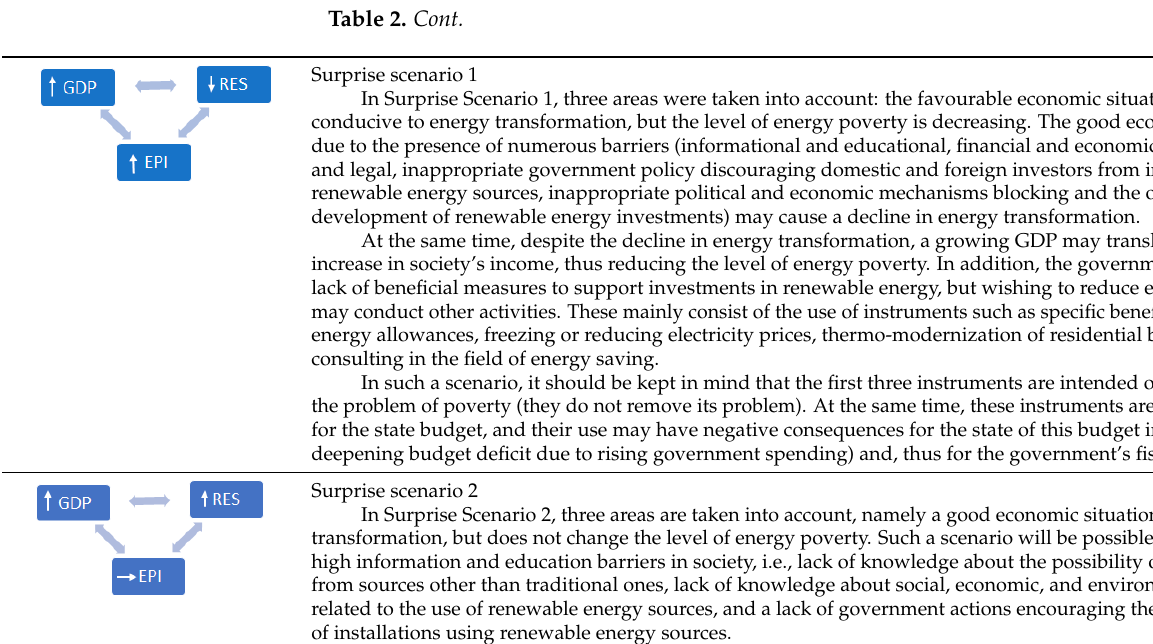
Table 3. Assessment of the factors influencing the development of energy from renewable